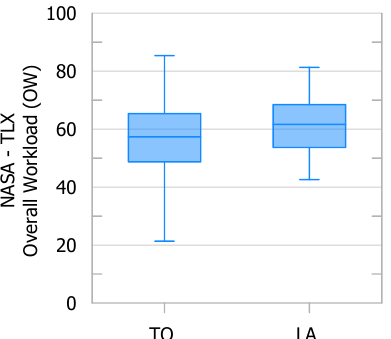
Figure 11. NASA-TLX workload assessment indexes for TO and LA segment over the sample.